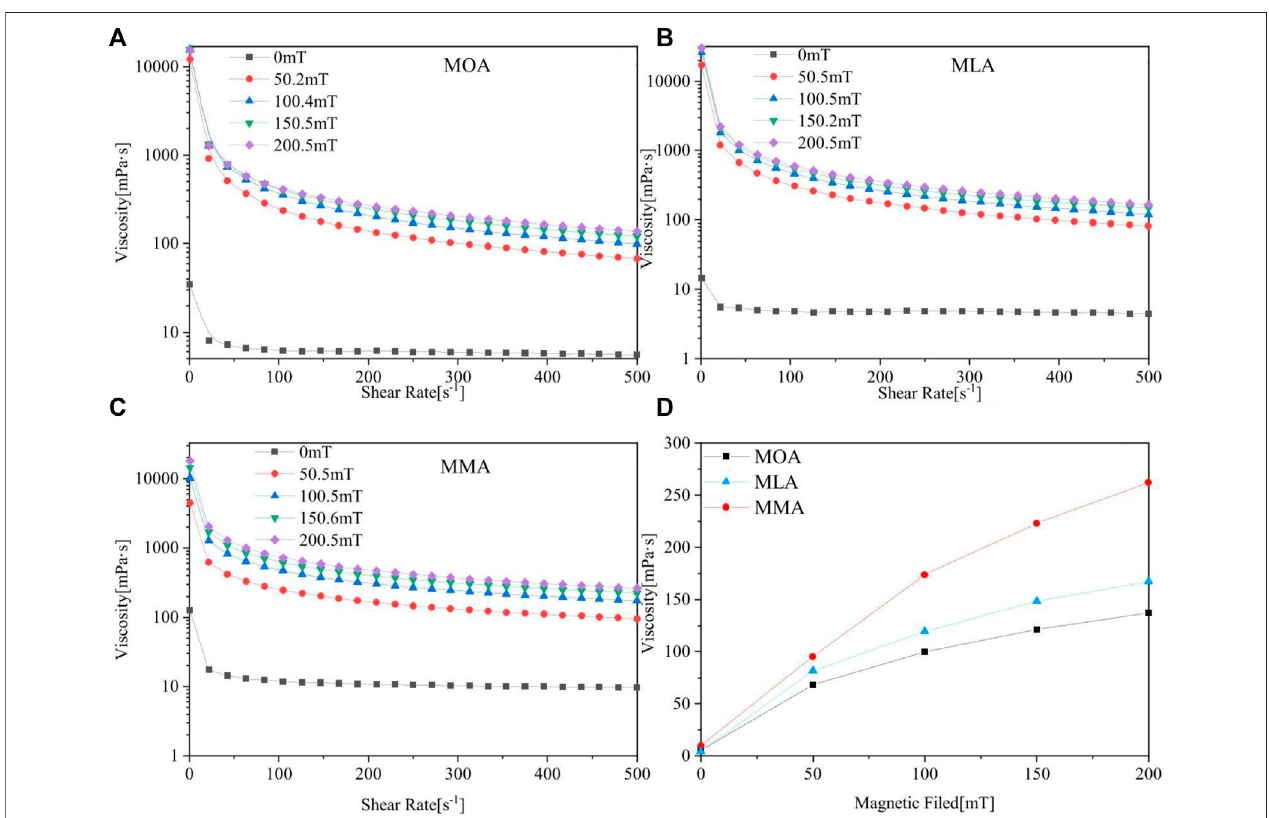
FIGURE 7 | Viscosity-strain images of (A) MOA, (B) MLA, and (C) MMA. (D) Maximum shear rate limiting viscosity-constant magnetic fi eld comparison images of three magnetic fl uids.